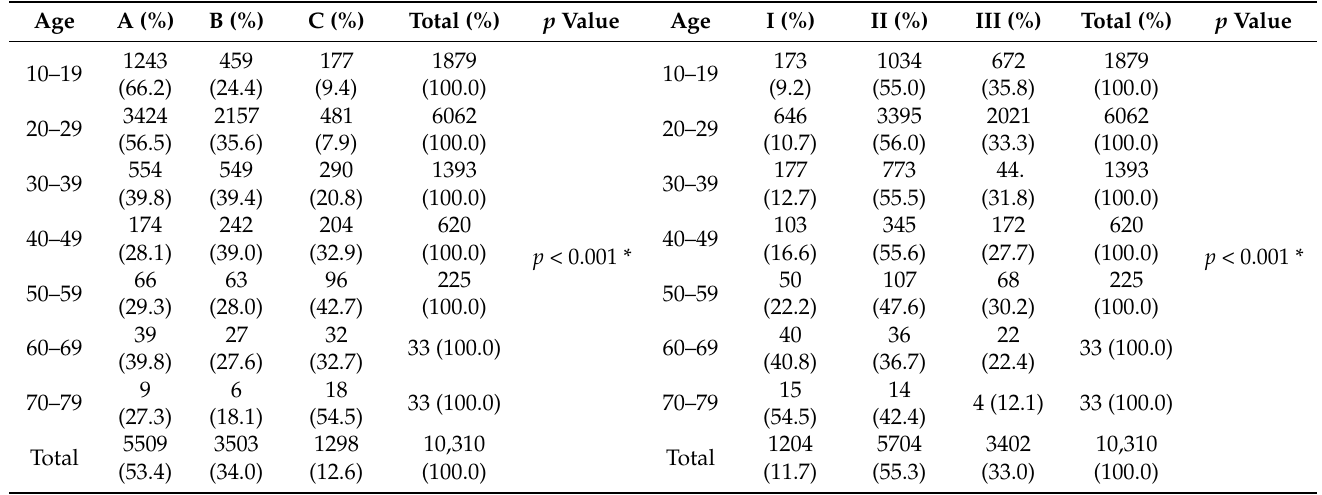
Table 3. Age distribution of the Pell and Gregory classification.